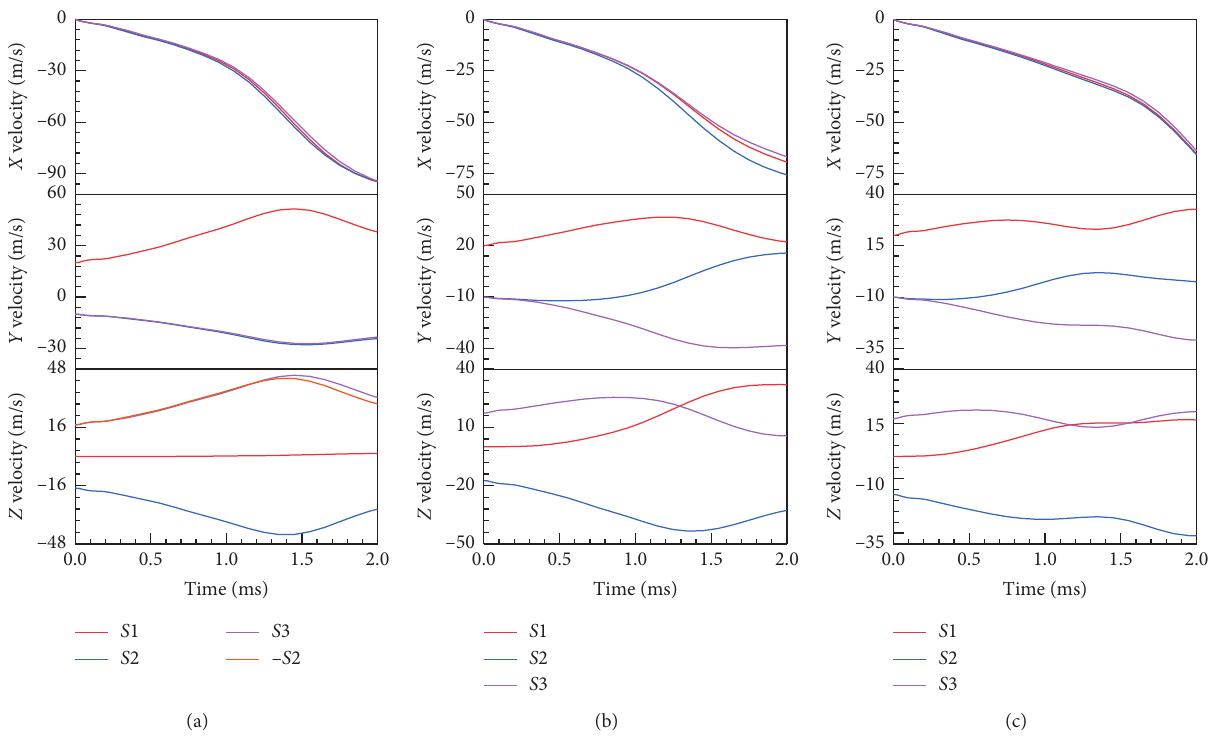
Figure 10: CG velocity of all sabots. Letters a, b, and c, respectively, stand for cases 1, 4, and 6. − S 2 is the opposite value of S